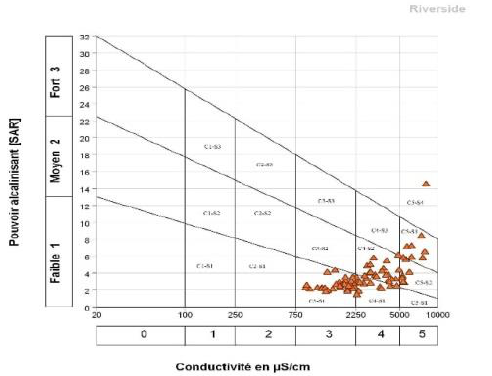
Figure 4. Classification of irrigation water (Richards, 1954).